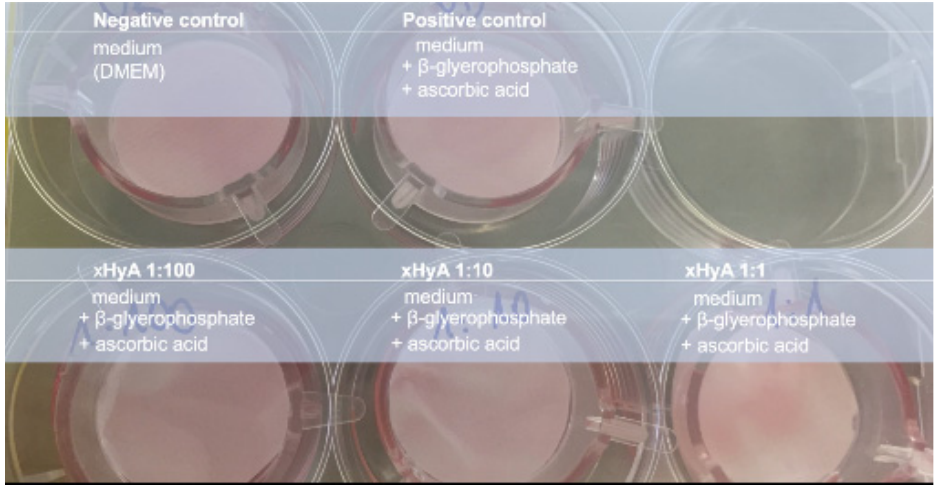
Figure 1. Test conditions disclosed for a single well with the installed insert on a 6-well plate.